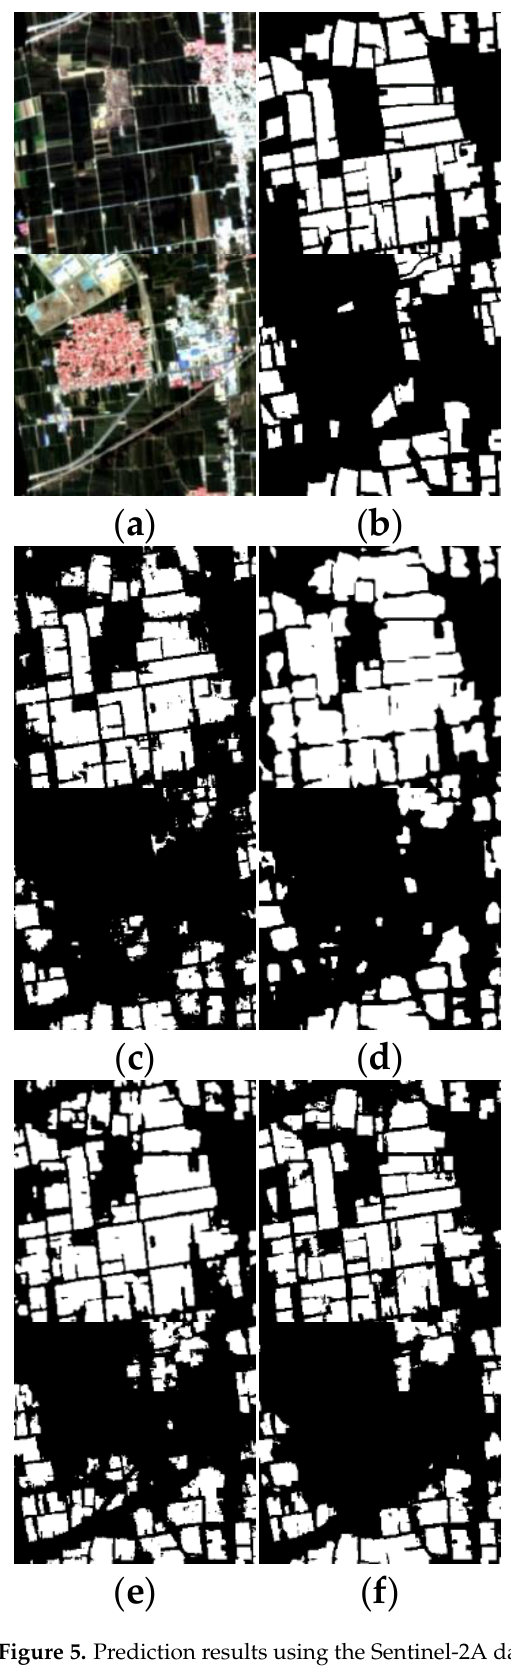
Figure 5. Prediction results using the Sentinel-2A dataset as training dataset: ( a ) Sentinel-2 original image, ( b ) label, ( c ) SegNet, ( d ) DeepLabV3+, ( e ) U-Net, ( f ) U-Net-CBAM.